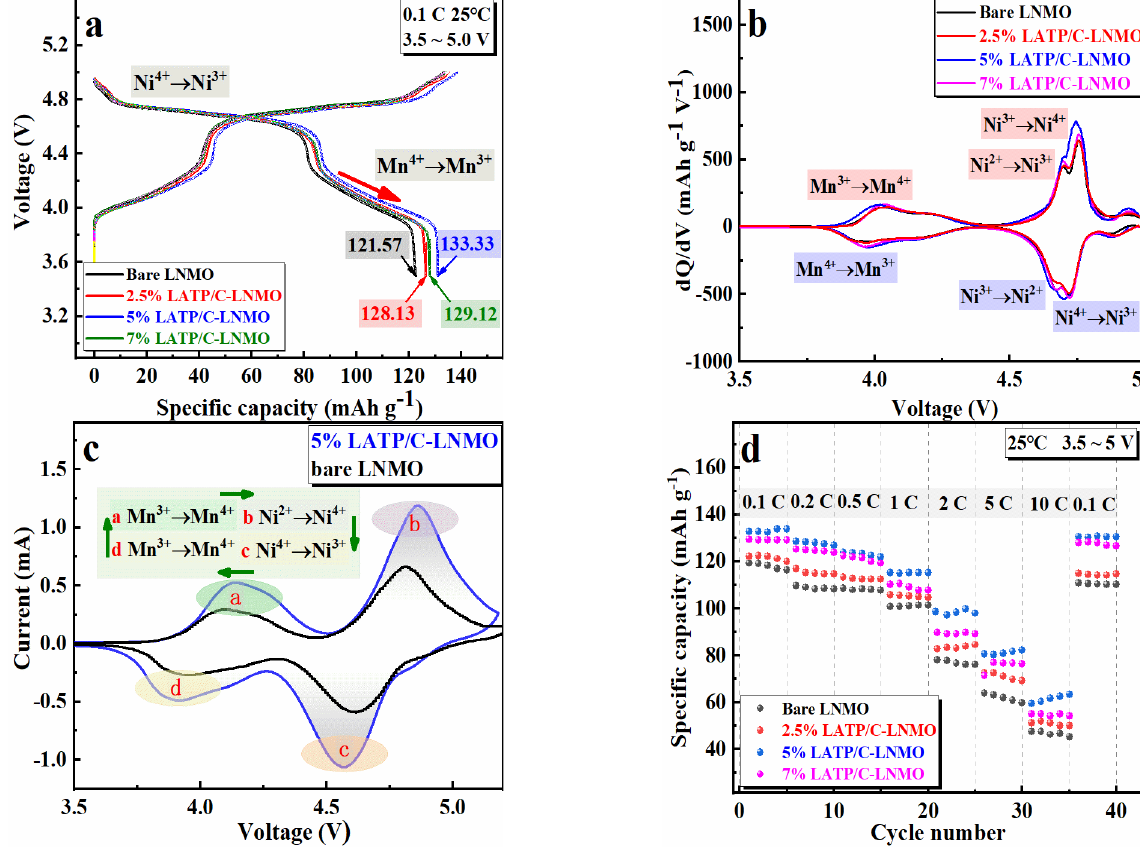
Figure 5. ( a ) Charge and discharge performance curves of the bare and LATP/C coated LNMO electrodes at 0.1 C, ( b ) the dQ/dV curves of the bare and LATP/C coated composite electrodes, ( c ) the CV curves of 5% LATP/C-LNMO and bare LNMO cathode at 0.1 mV s − 1 , ( d ) various rates (0.1 C, 0.2 C, 0.5 C, 1 C, 2 C, 5 C,10 C) discharge performance comparison of the bare and the LATP/C-coated composite electrodes.